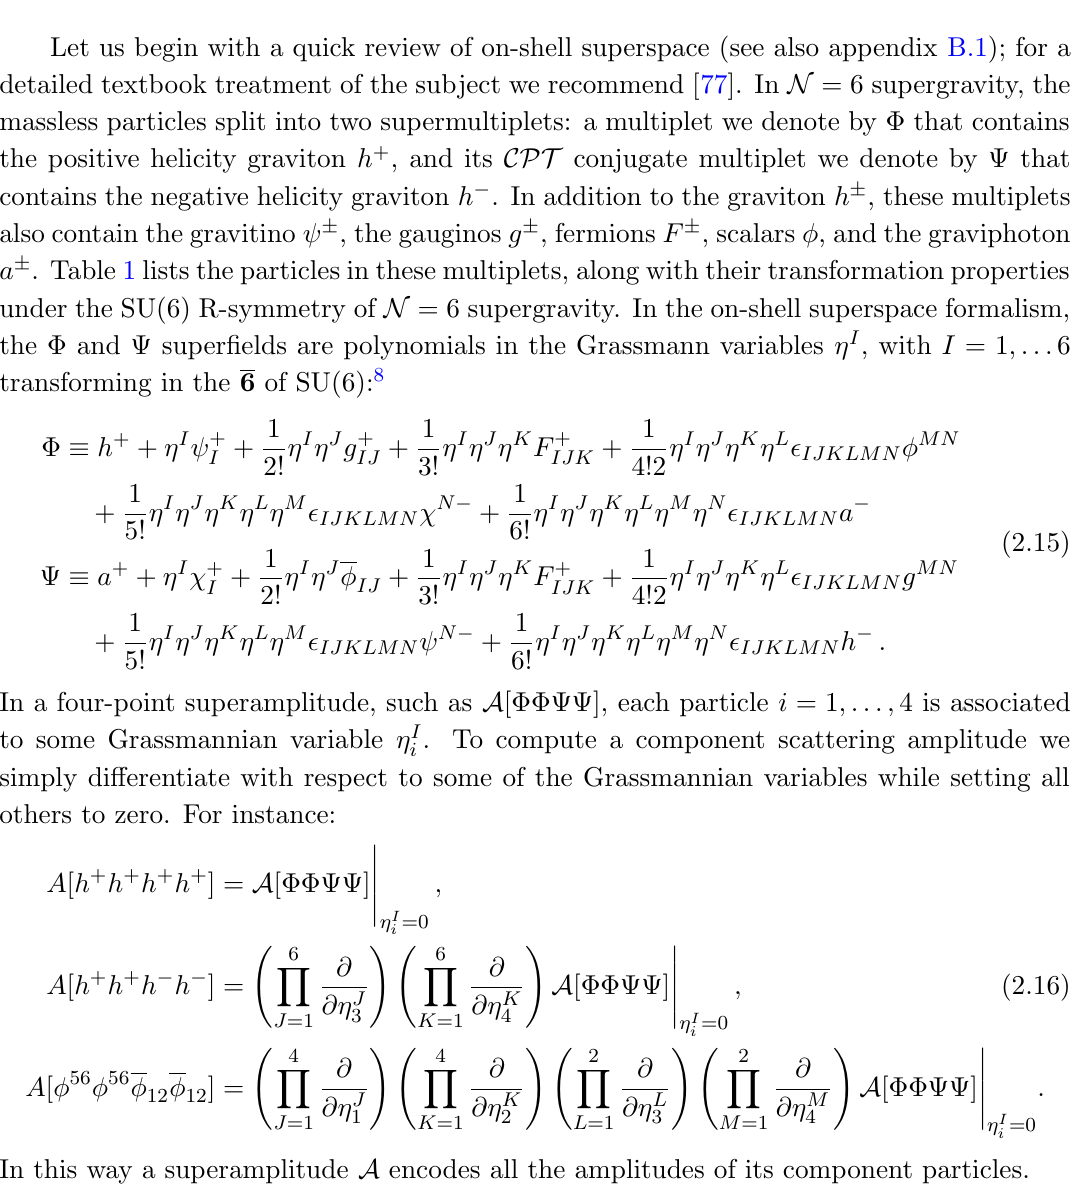
Table 1 . Massless particles in N = 6